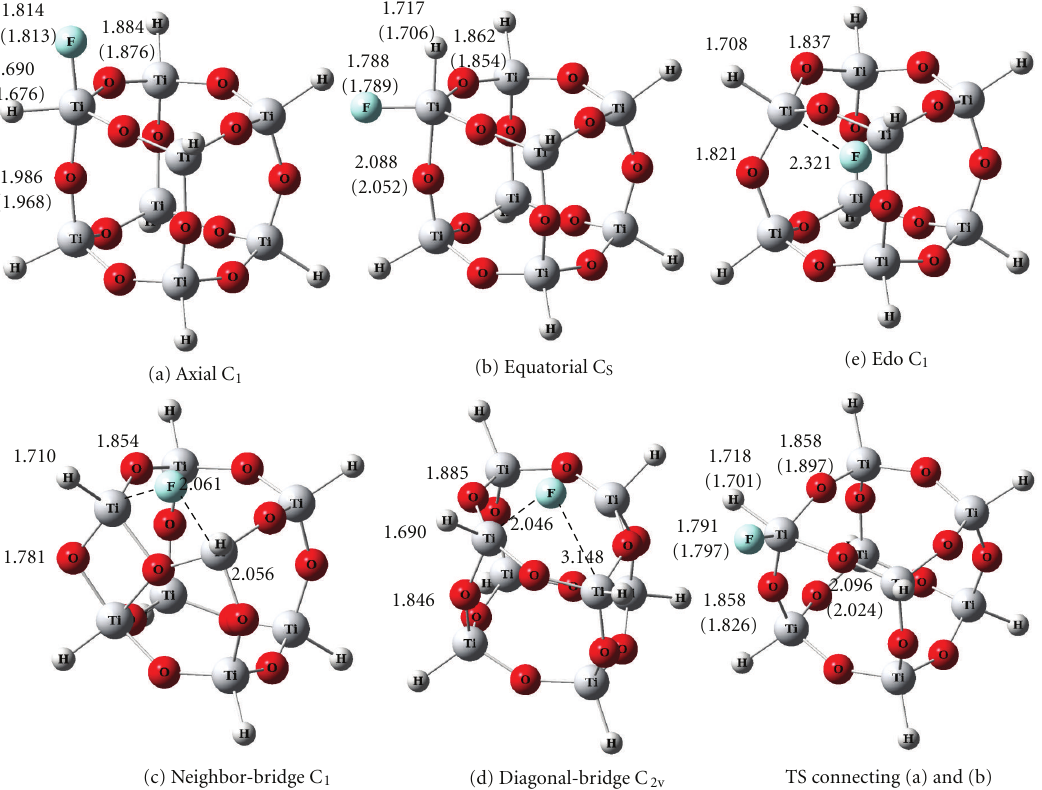
Figure 4: The B3LYP/6-311+G(d) and HF/6-311+G(d) (in parentheses) optimized geometries of exohedral and endohedral complexes of F − and Ti-T 8 and the transition state for the “Axial” (a) “Equatorial” (b) isomerization in angstroms.